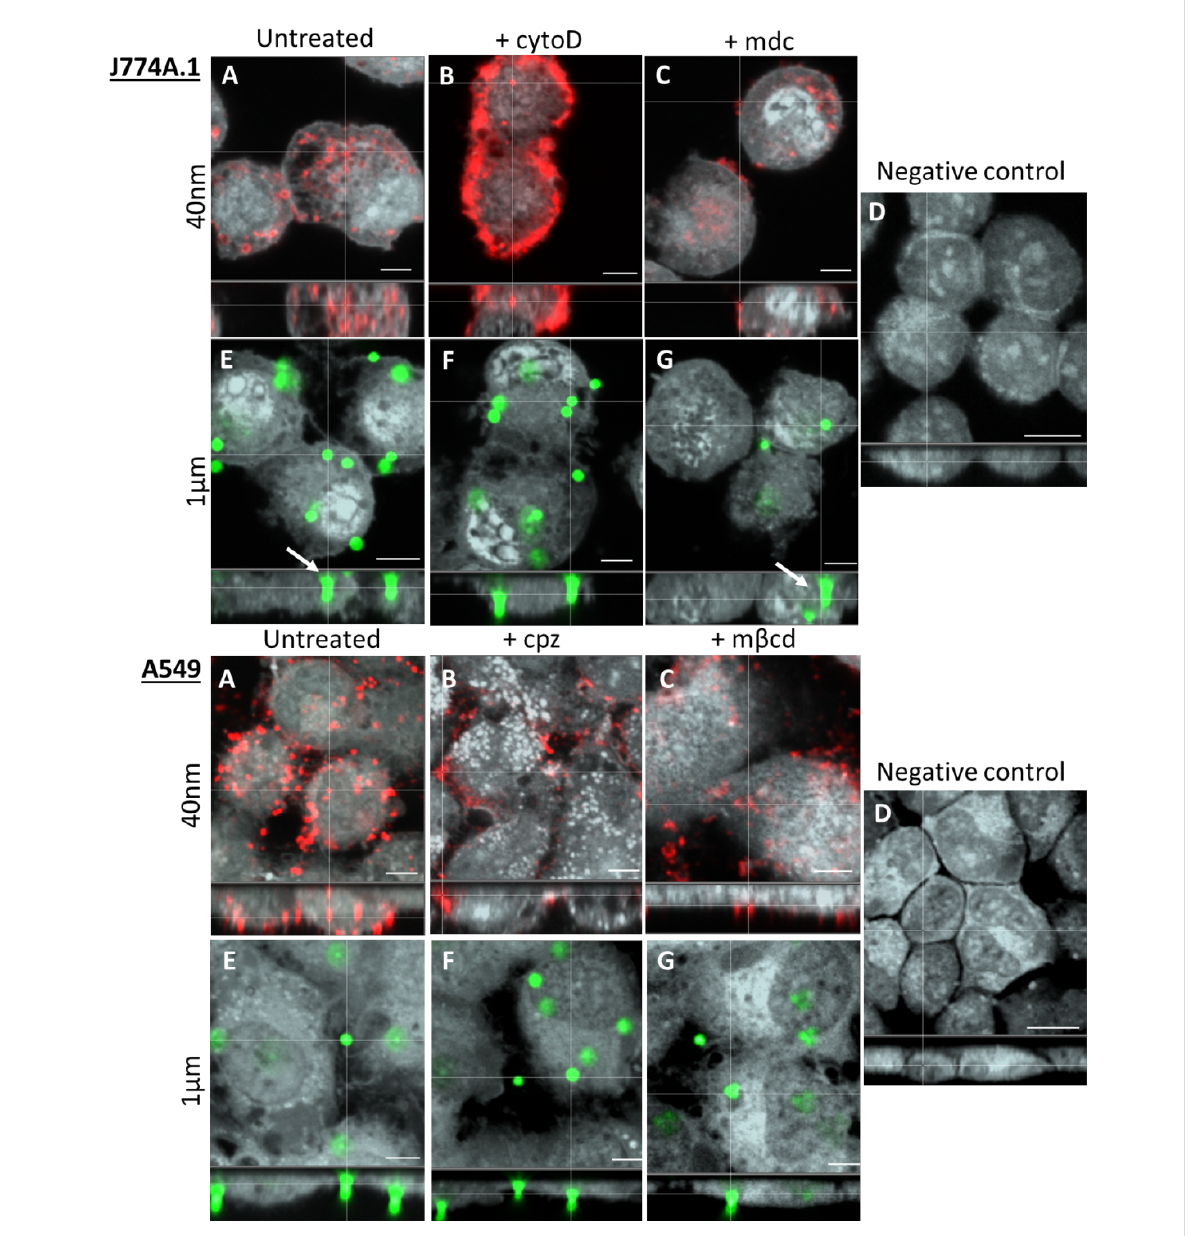
Figure 5: Laser scanning microscopy imaging revealed particle uptake in J774A.1 and A549 cells. (A–C) Uptake of 40 nm PS NPs (NP: red, cytosol: grey). (A) Untreated cells with 40 nm NPs. (B) 40 nm NPs and cytochalasin D (cytoD) in J774A.1 and chlorpromazine (cpz) in A549 cells. (C) 40 nm NPs and monodansylcadaverine (mdc) in J774A.1 cells and methyl- β -cyclodextrin (m β cd) in A549 cells. (D) Negative control. (E–G) Uptake of 1 µm PS particles (particles: green, cytosol: grey). (E) Untreated cells with 1 µm particles. (F–G) 1 µm particles with the same adequate inhibitors. Scale bar: 5 µm. White arrows represent intracellular events of 1 µm particles in J774A.1 cells. The negative controls have a scale bar of 10